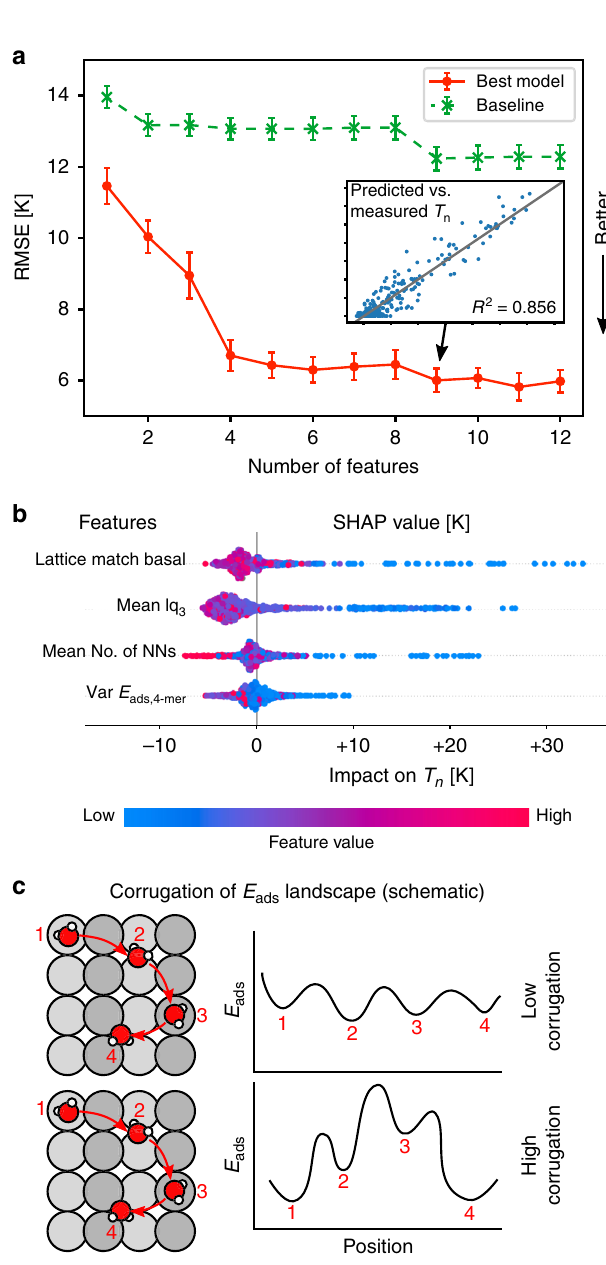
Fig. 3 Model performance and descriptor identi fi cation. a Performance of the linear baseline model and the best ML model identi fi ed in this study as a function of the number of included descriptors. The inset shows the correlation of predicted and measured T n for the ML model using nine descriptors. Error bars represent the standard deviation over 20 independent train-test splits. Source data are provided as a Source data fi le. b SHAP values (model impact) for the fi rst four included descriptors from panel ( a ). These are (i) the lattice match to the basal face of ice; (ii) the mean lq 3 (as de fi ned in the text); (iii) the mean number of nearest neighbors within 3.4 Å; and (iv) the variance of water tetramer adsorption energies. The color scale goes from the lowest (blue) to the highest (red) value present in our dataset for each descriptor, respectively. c Sketch illustrating substrates (top view on the left) that are structurally similar. The water – monomer adsorption energies ( E ads shown schematically on the right) for different positions are not very different in the case on the top substrate while in the bottom substrate they are very different, leading to a more corrugated adsorption energy